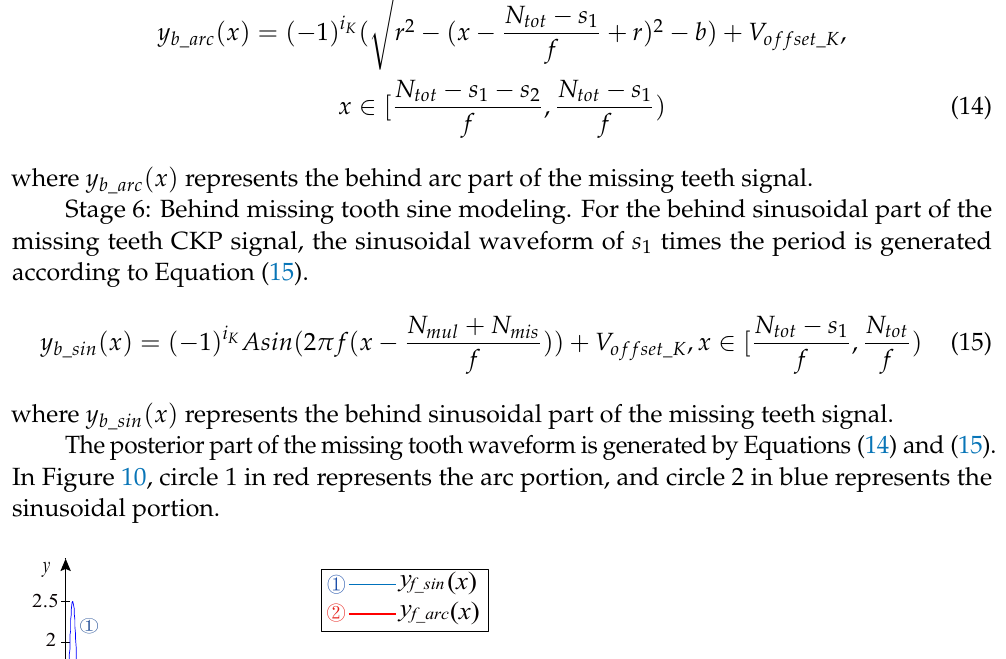
Stage 5: Behind missing tooth arc modeling. For the behind arc part of the miss- ing teeth CKP signal, the center coordinate of the circle is ( s 1 waveform with s 2 times the period is generated according to Equation (14):